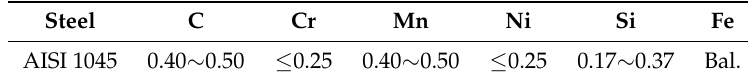
Figure 1. SEM images of cladding powder. Table 1. Chemical composition of AISI 1045 carbon steel (wt. %).